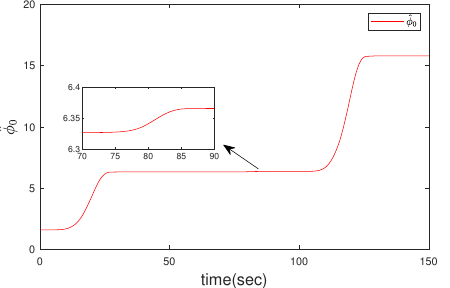
Figure 10. The estimation curve of unknown parameter ψ 0 in this